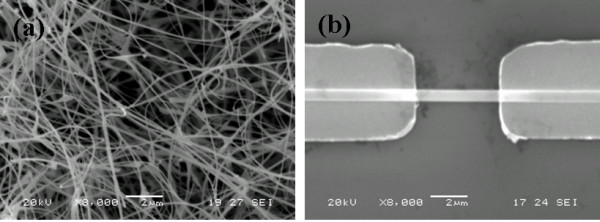
SEM images of SnO2 nanobelt. (a) SEM images of SnO2 nanobelt. (b) SEM image of a single SnO2 nanobelt across the Au electrodes.